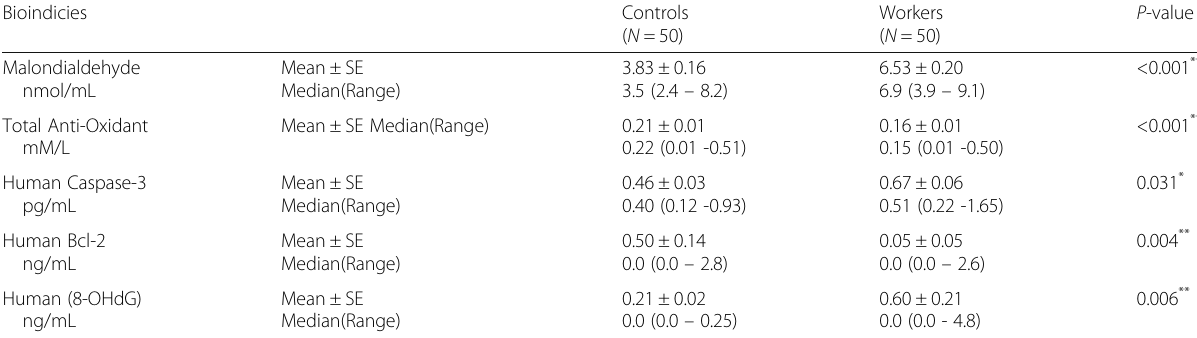
Table 5 Biochemical markers in occupationally exposed group versus control group Bioindicies